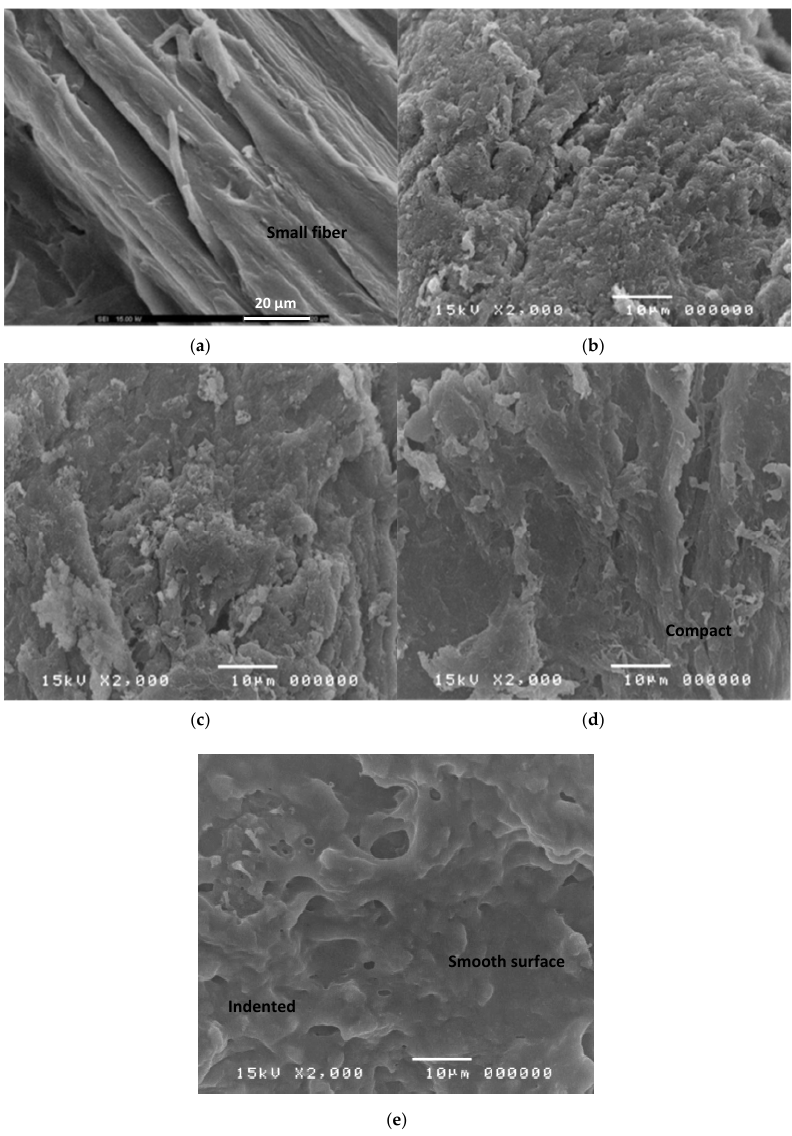
Figure 6. Scanning electron micrographs of ( a ) cellulose from nata de coco and CMC n powder with ( b ) MCA 6 g/15 g of cellulose, ( c ) MCA 12 g/15 g of cellulose, ( d ) MCA 18 g/15 g of cellulose, and ( e ) MCA24 g/15g of cellulose.